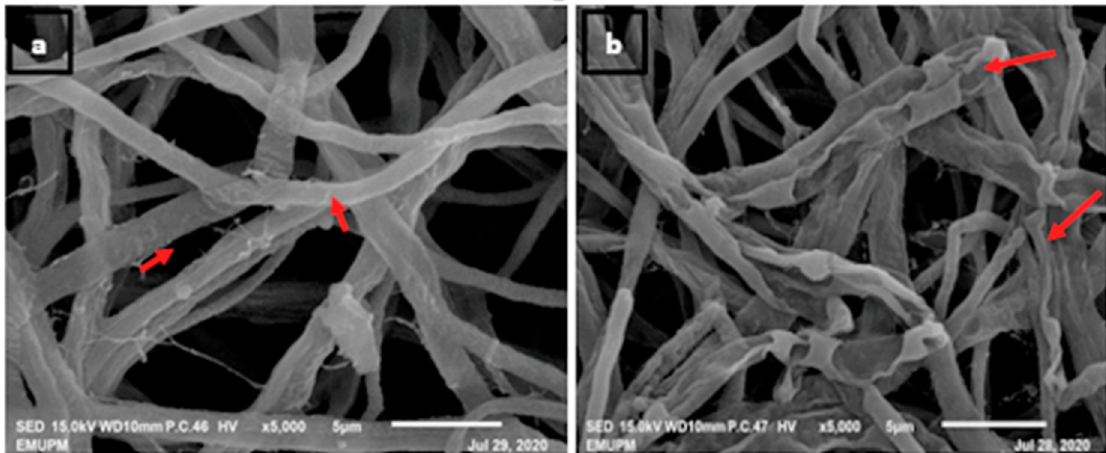
Figure 1. Scanning electron micrograph of G. boninense mycelia grown on PDA media. ( a ) Smooth, compact structure with distinctive clamp connection (arrow) in the healthy mycelium. ( b ) Mycelium excised from benzoic acid incorporated media showing distortion with shrivelling (arrow), holes and rupture (arrow) in mycelial structure at (5000 × ).